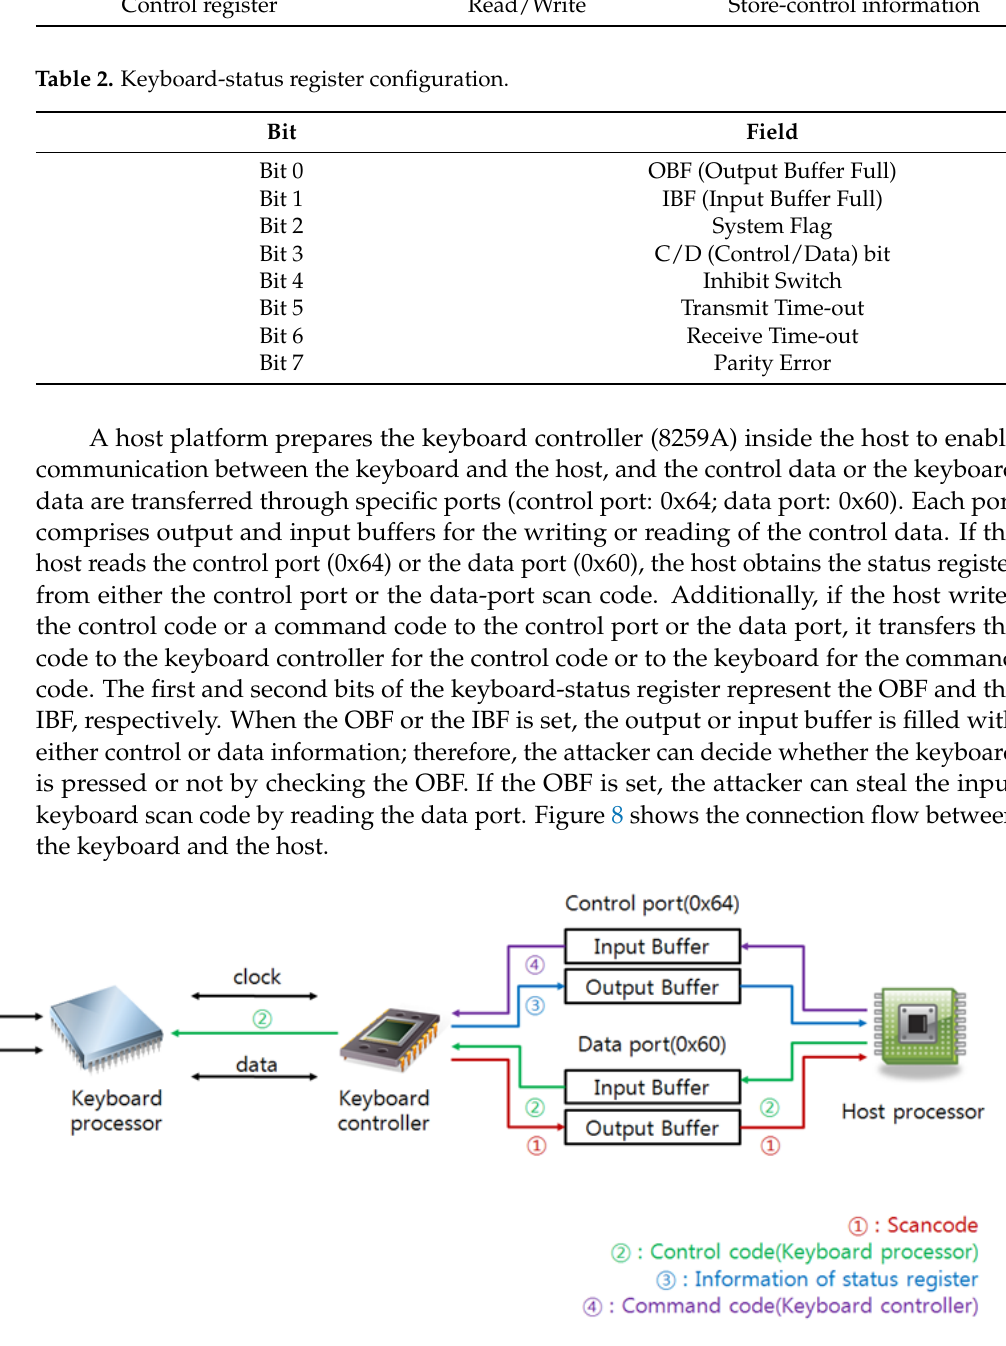
Figure 8. The connection flow between the keyboard and the host .